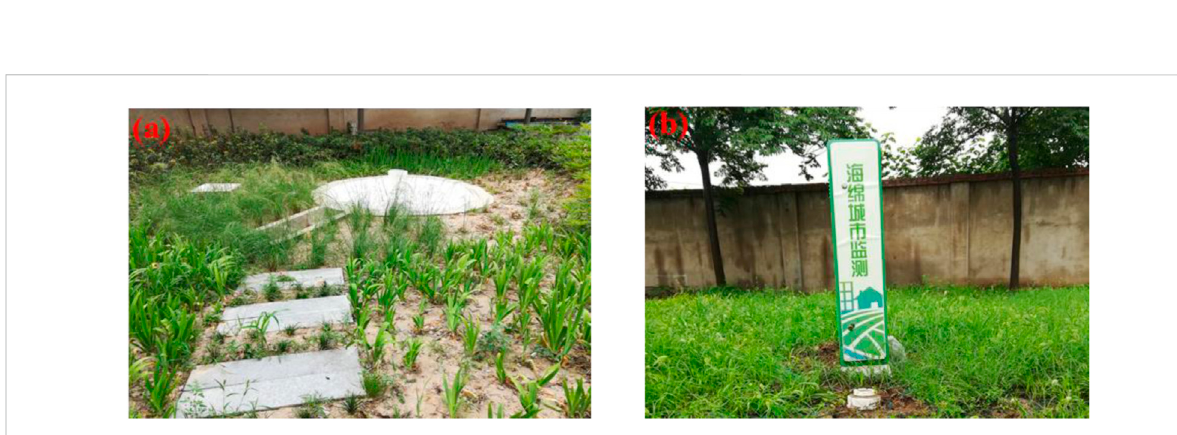
FIGURE 3 The scene drawing of CRIs and groundwater monitoring well (J1). Note: (A) CRIs; (B)